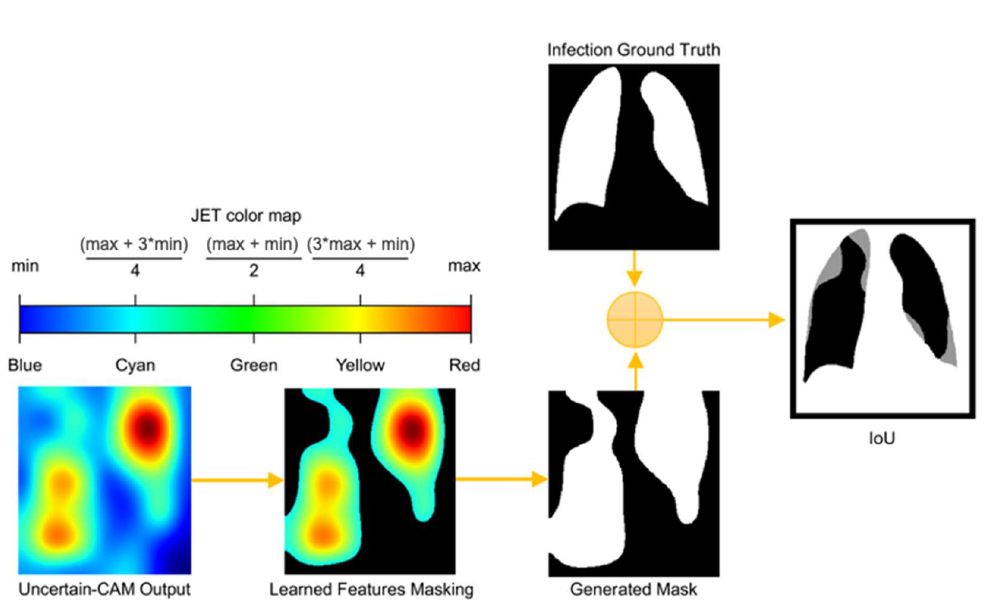
Figure 2. Process of computing IoU from Uncertain-CAM Output and Ground Truth. The generated heatmap is masked based on color threshold and is compared with ground truth masked to generate IoU, which describes how much generated masked is aligned with the ground truth masked.